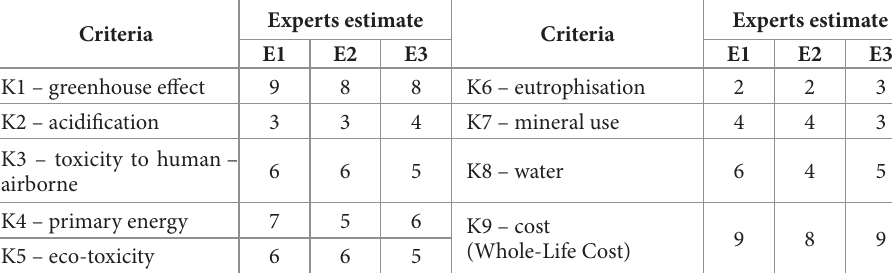
Table 7. The final assessment list of solutions Building Estimate Wall Estimate Floor Estimate